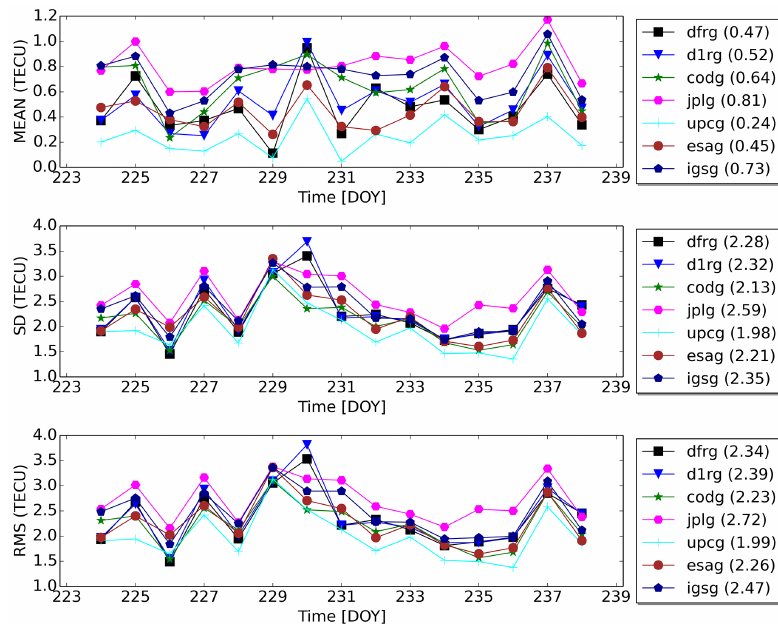
Figure 5. Results of the statistical evaluations presenting the differences between the observed and computed dSTEC values at the station PIMO. The investigation covers the days DOY 224 to DOY 238, 2016: (upper panel) mean of deviations, (middle panel) standard deviations and (bottom panel) RMS values of errors in terms of